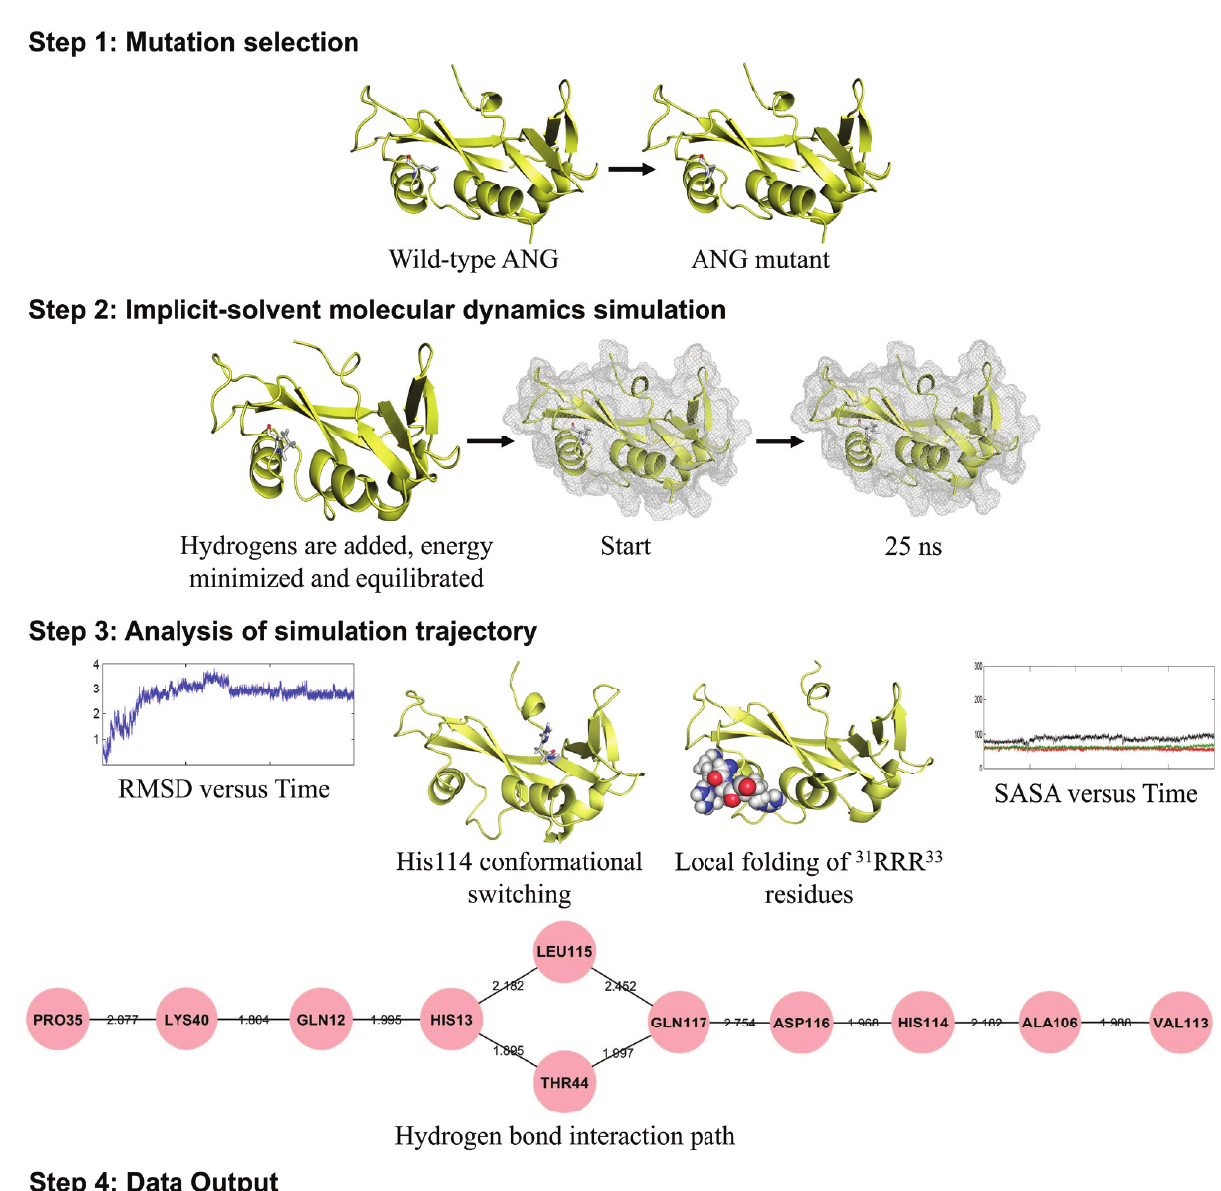
Figure 1. ANGDelMut protocol. Steps involved to predict whether an ANG mutation will be ALS causative or not, with a brief understanding of the mechanism(s) of its loss-of-functions, implemented in the ANGDelMut web-tool. In Step 1, the user submits a missense ANG mutation to the web-tool and the mutated ANG protein is prepared. Next, in Step 2, an implicit-solvent MD simulation for 25 ns is performed after adding hydrogen atoms, and executing energy minimization, equilibration. After completion of the simulation, in Step 3 certain structural and dynamic markers/attributes from the MD simulation trajectory are analyzed, namely, the RMSD versus time, conformational switching of catalytic residue His114, presence of hydrogen bond interaction path from the site of mutation to His114 mediated through Leu115, local folding of nuclear localization signal residues 31 RRR 33 and change in SASA versus time. After analysis in Step 3, the PDB file extracted from the MD simulation and an excel file containing the RMSD data are uploaded into the